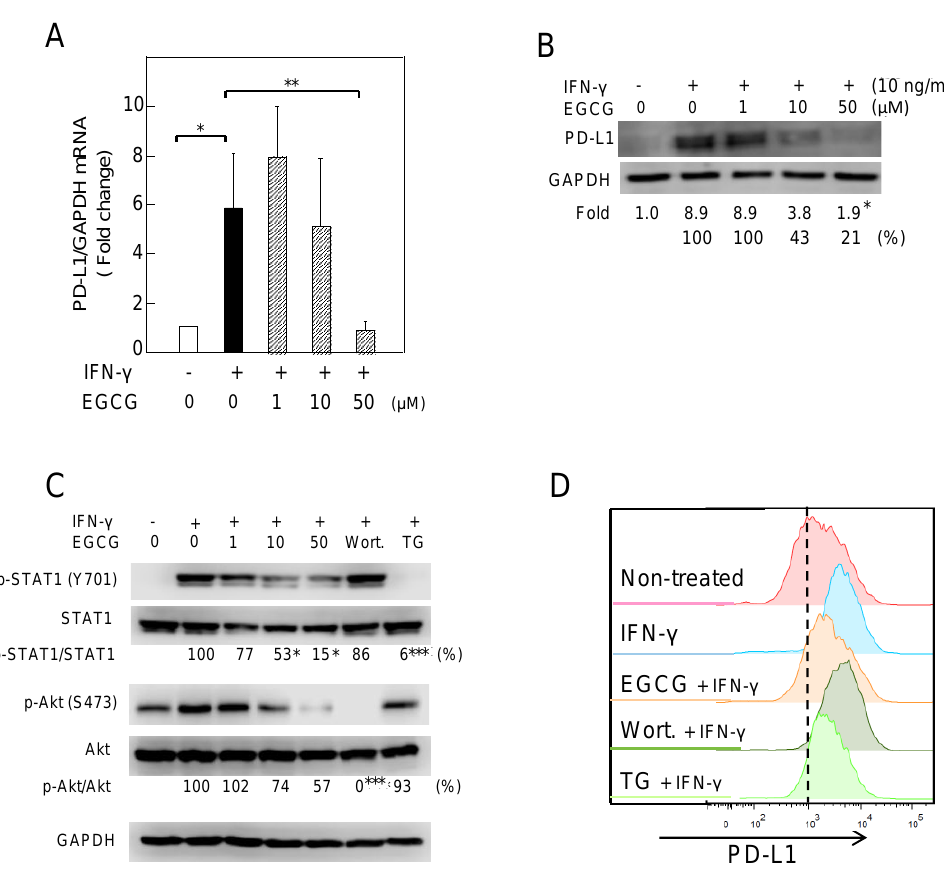
Figure 2. Downregulation of IFN-γ–induced PD-L1 protein and inhibition of STAT1- and Akt-phosphorylation in A549 cells treated with (−)-epigallocatechin gallate (EGCG). ( A ) PD-L1 mRNA expression, ( B ) PD-L1 protein, ( C ) phosphorylation of STAT1 and Akt, and ( D ) cell-surface PD-L1. “−“ and “+” indicate in the absence or presence of IFN-γ (10 ng/mL). Numbers indicate average percentage compared with IFN-γ–treated cells. * p < 0.05, ** p < 0.01, *** p < 0.001. GAPDH, glyceraldehyde-3-phosphate dehydrogenase.